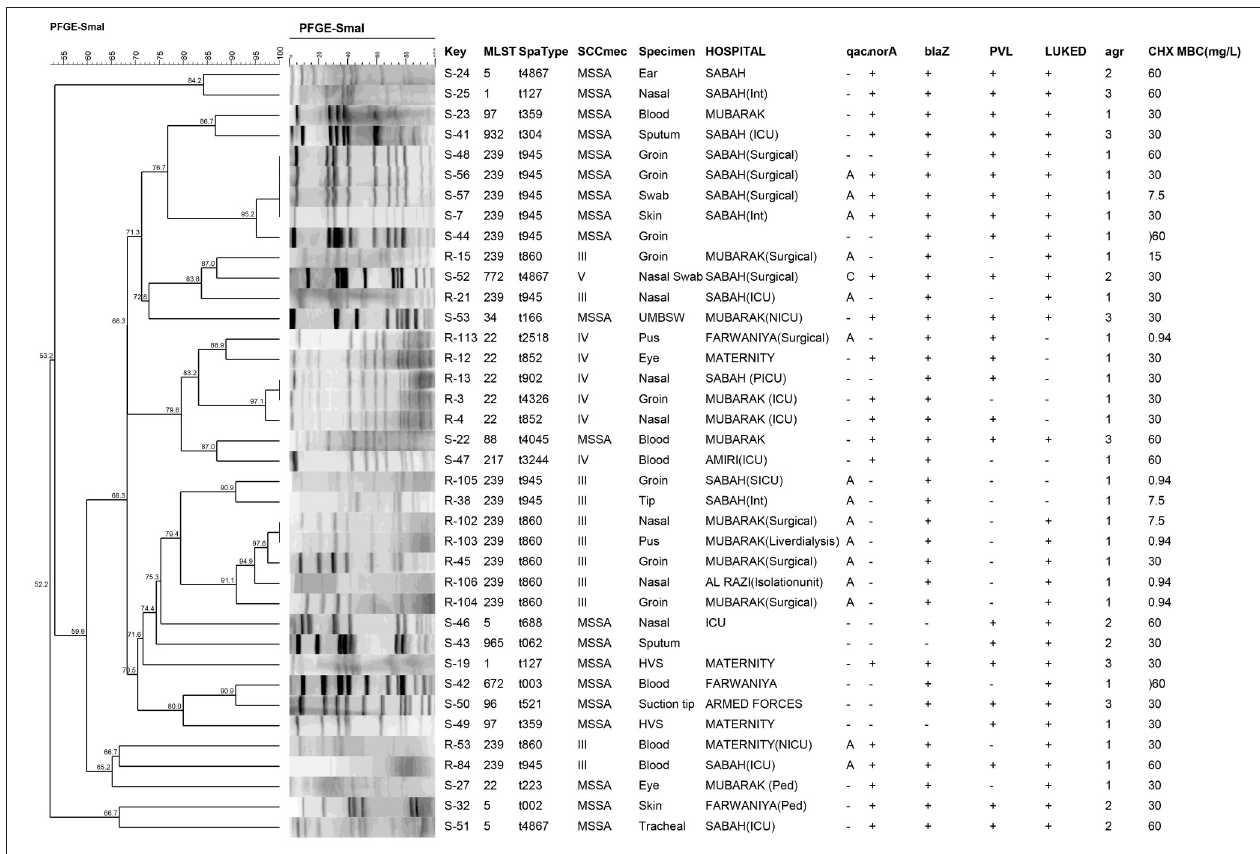
FIGURE 4 | PFGE profiles of qac ( + ) MRSA and MSSA and qac (–) isolates with reduced susceptibility to chlorhexidine. The hierarchic Cluster analysis and phylogenetic tree after digestion with Sma I is shown. PFGE banding patterns were analyzed using DICE/UPGMA with an optimization of 1.5% and a tolerance of 1.5% generated by BioNumerics software (v.7.1). The percentage of similarities between the clusters are